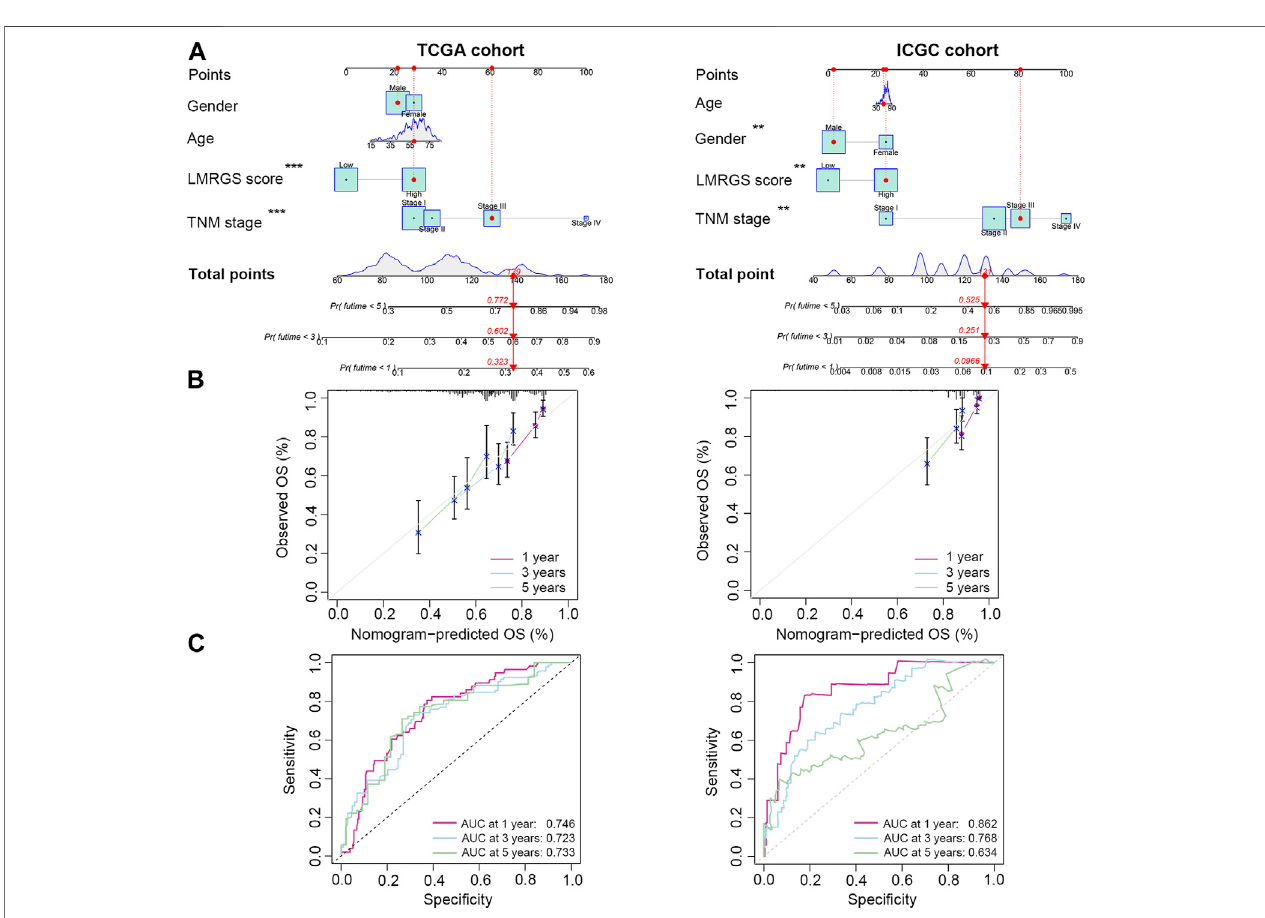
FIGURE 4 | A nomogram was generated to estimate the survival rate of HCC patients. (A) Development of a nomogram by combining LMRGS score with age, gender, and TNM stage to predict the survival probability. (B) Calibration plots of the nomogram. (C) ROC curves of the nomogram. * p < 0.05, ** p < 0.01, *** p < 0.001.